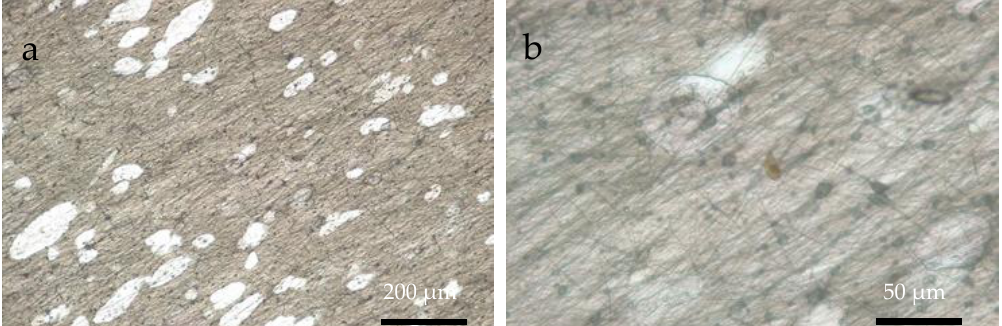
Figure 5. OM images of A-chitosan fibers supported on ITO substrate at ( a ) 10 × and ( b ) 40 × magnifications.